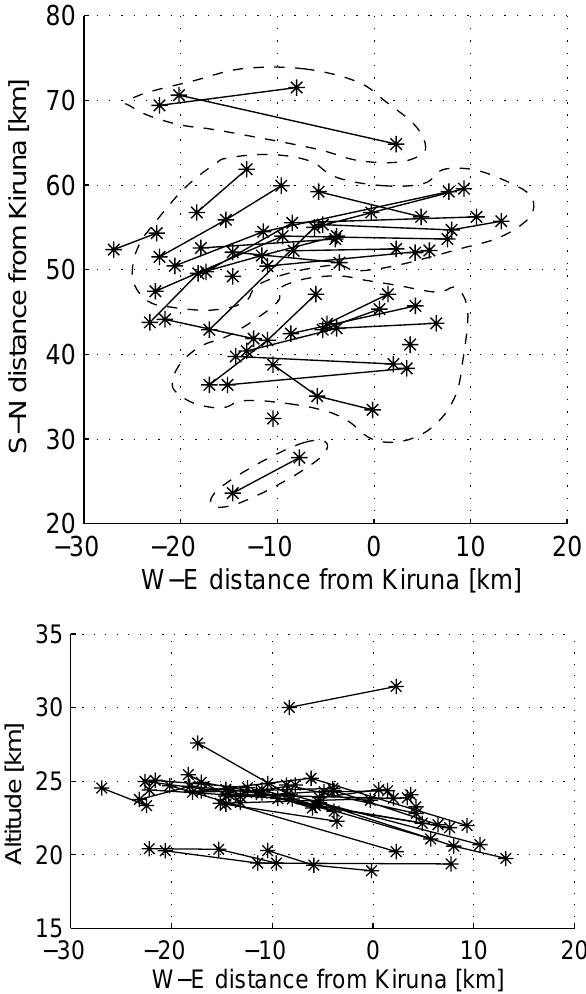
Fig. 11. Identifiable contour lines from triangulations using all im- age pairs with as many triangulation points as possible per pair. The points show the triangulated positions (as marked by red dots in Fig. 14); points belonging to the same visual contour features of the PSCs are joined by lines. These PSC “edges”, and hence the PSCs, show a grouping in structures separated 10–20km. ( a ) : W-E/N-S location; ( b ) :